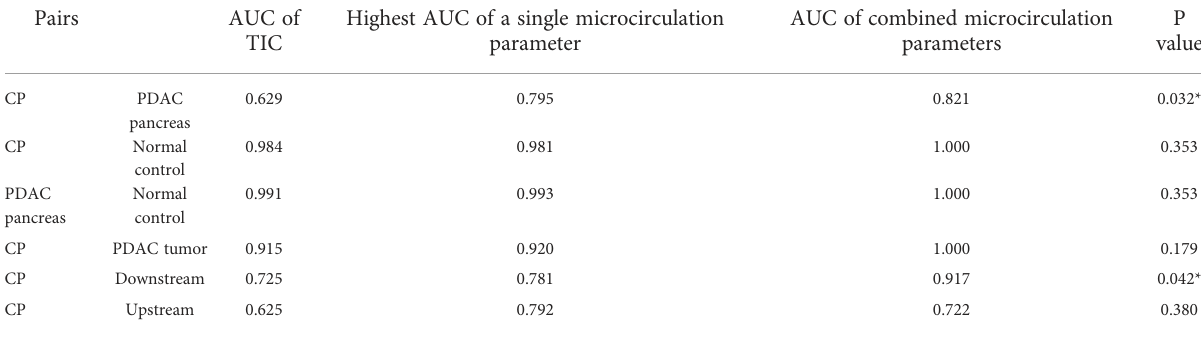
TABLE 5 The comparison of the differentiation ability of TIC approach versus quantitative DCE approach. Pairs AUC of